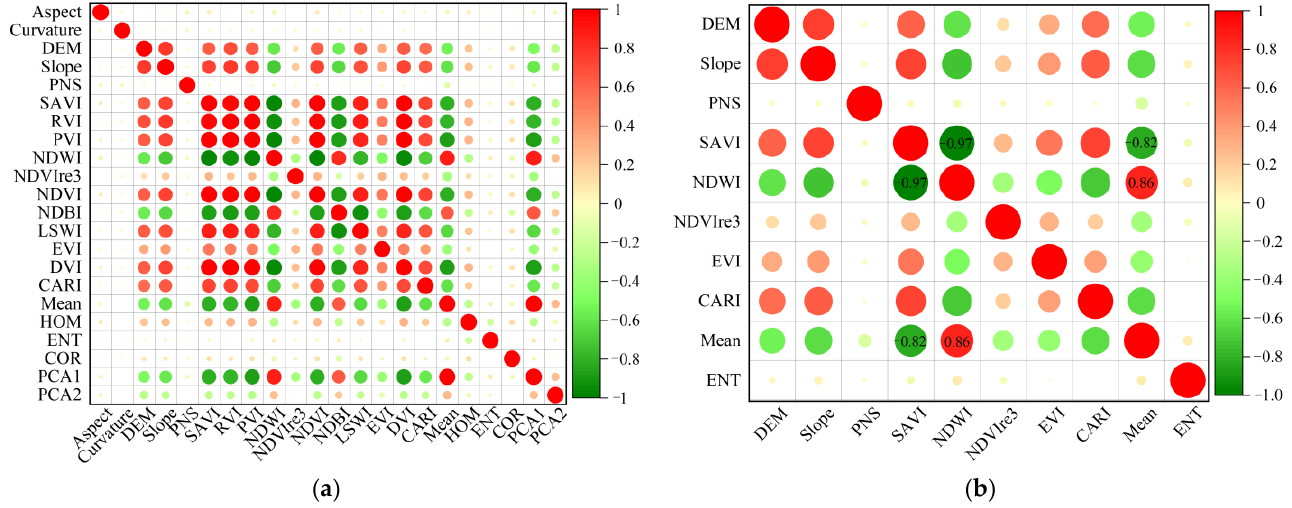
Figure 9. Comparison of correlation between initial features and between preferred features. ( a ) Correlation between initial features, ( b ) correlation between features in MC.